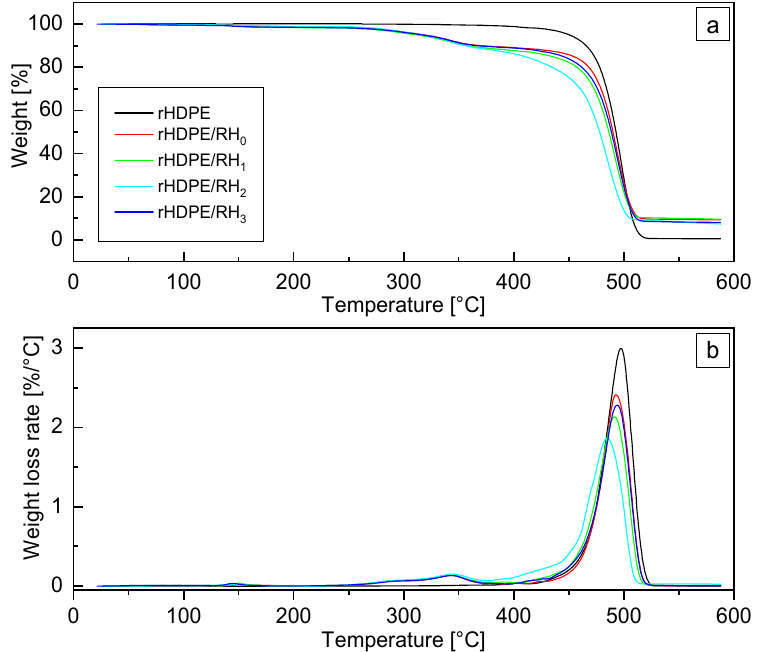
Figure 11. ( a ) TG, ( b ) DTG for rHDPE/RH composites. On the other hand, reinforced composites exhibited a two-step thermal degradation. From 250 to 400 °C, the weight loss can be mainly attributed to rice husk ( Error! Reference source not found. ). The second stage was defined by the rHDPE matrix. Reported varia- tions in mass loss and maximum rate of weight loss (DTG max ) were due to the thermal stability of the coupling agents. The NAT composite showed an early beginning for the polymer degradation phase. Among the compatibilized composites, rHDPE/RH 3 pre- sented the higher DTG max of 494.39 °C, followed closely by rHDPE/RH 1 with 491.50 °C. Despite the influence of additives on the rHDPE/RH thermal behavior, HDPE process temperatures were lower than the ones observed in the thermograms. 3.5. Mechanical Properties Tensile and impact values for rHDPE and reinforced composites are presented in Table 5. Neat rHDPE exhibited a ductile behavior with an elasticity modulus of 0.929 GPa and ultimate strength of 23.78 MPa. These properties were significantly affected by add- ing 20% of rice husk. The tensile strength decreased to 20.48 MPa, while Young’s modulus